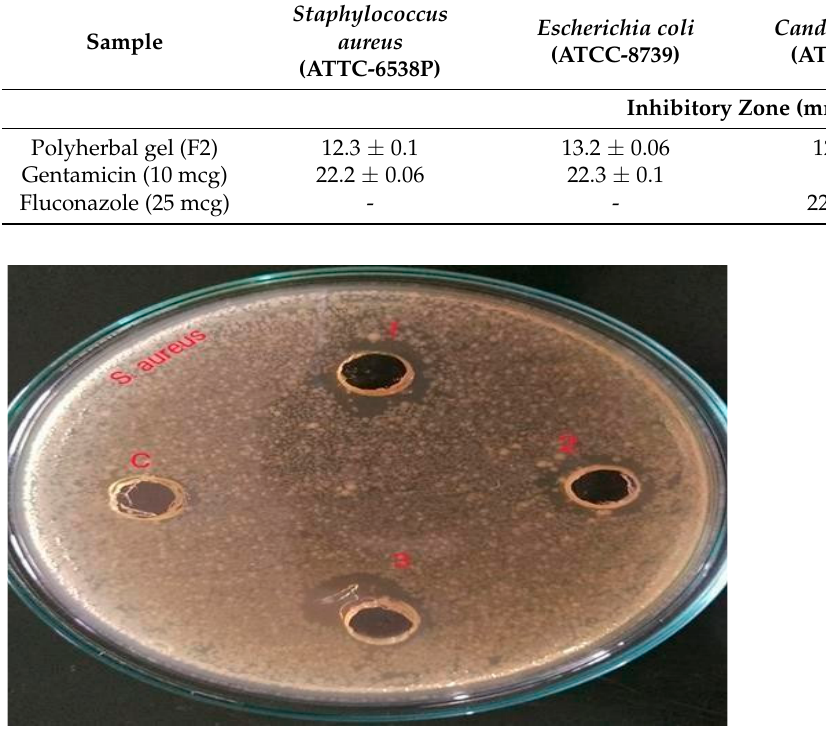
Figure 3. Zone of inhibition of Vigna radiata extract toward Candida albicans ( 1 ) 12.4 mm, ( 2 ) 12 . 3 mm, ( 3 ) 12.5 mm and ( c ) control.